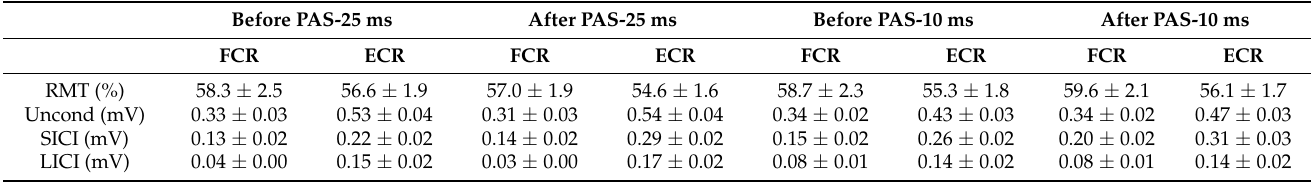
Table 3. MEP amplitudes and RMT, SICI, and LICI values for the FCR and ECR muscles before and after